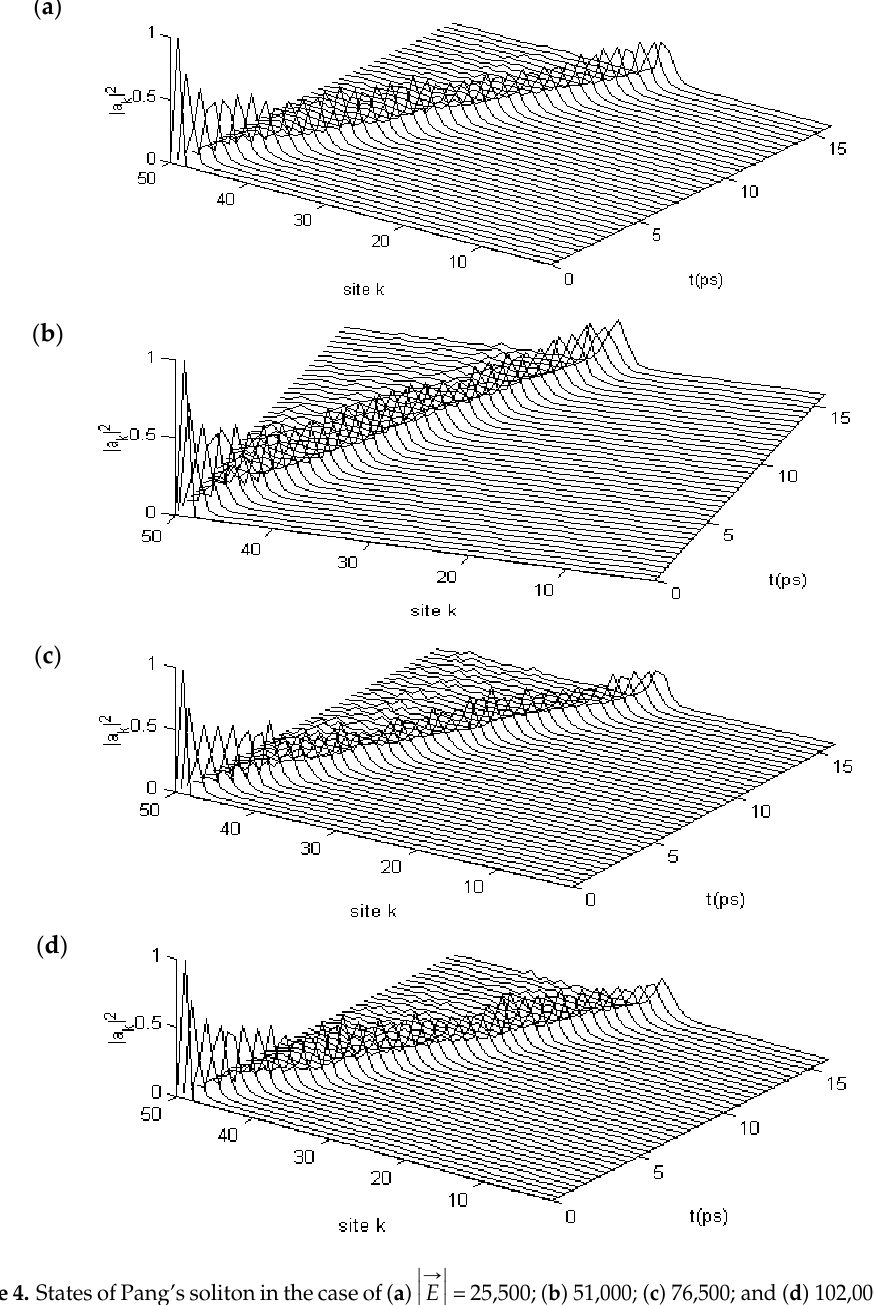
Figure 4. States of Pang’s soliton in the case of ( a ) respectively, where “site k” denoted the number of amino acid residue, ” n ”.